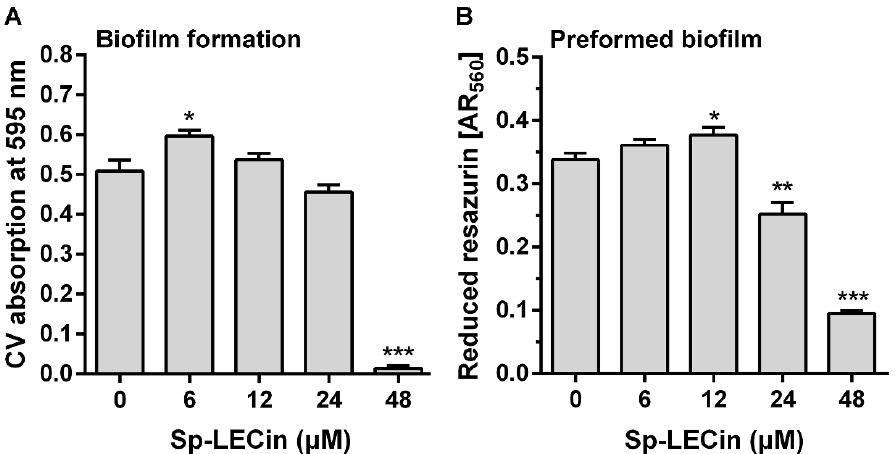
Figure 5. Effect of Sp-LECin on ROS production in P. aeruginosa . Intracellular ROS was monitored using 2,7-dichlorofuorescin diacetate (DCFH-DA) probe after treatment with different concentrations of Sp-LECin (0, 12, 24 and 48 µ M) for 0.5 ( A ) and 1 h ( B ), respectively. LL-37 was used as a positive control. Significant difference between control group and AMP treatment group was indicated by asterisks as *** p < 0.001. The bars indicate the mean ± standard error of mean ( n = 5).